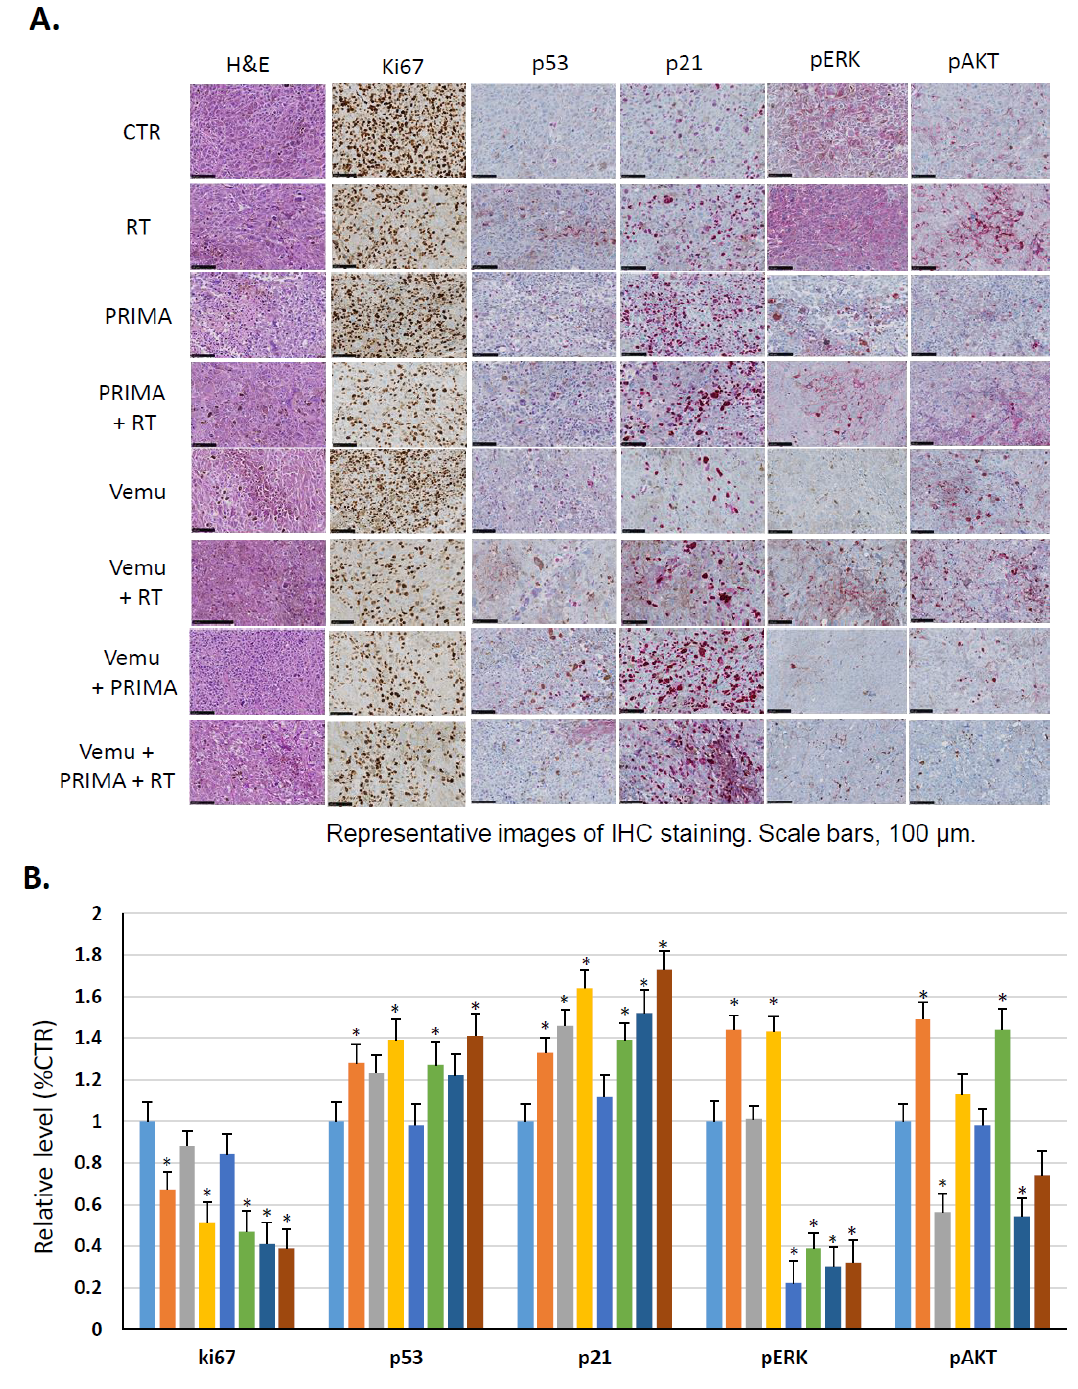
Figure 6. MAPK kinase and PI3K pathways reactivation confers resistance of BRAF mutant melanoma cells to radiation in a nude mice model. ( A ) Immunohistochemistry staining for Ki67, p53, p21, pERK, and pAKT in non-irradiated cells and irradiated cells, untreated or treated with vemurafenib (45 mg / kg) and / or PRIMA-1 Met (50 mg / kg). ( B ) Relative expression of immunohistochemistry data reporting Ki67, p53, p21, pERK, and pAKT compared to control. Data are presented as means ± SEM from three mice compared to untreated tumors (CTR). The level of significance is indicated by * p < 0.05 (Student’s t ‐ test).